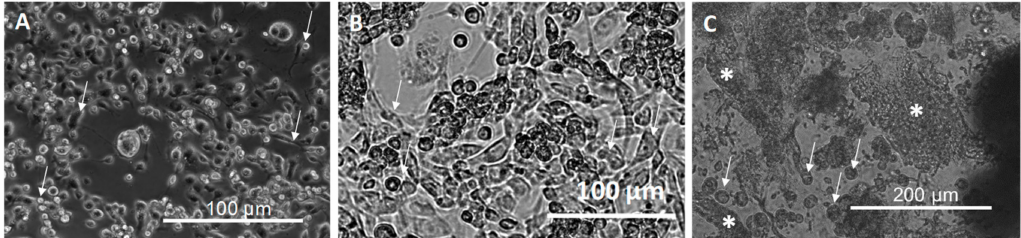
Figure 4. Images acquired in bright field using inverted microscopy of the MDA-MB231 cells cultured in 2D monolayer (10 × magnification) observed after ( A ) 24 h and ( B ) 3 days and ( C ) 3D sca ff old (20 × magnification) and in m. White arrows indicate the cells, whereas white stars in panel ( C ) the extracellular matrix deposed by